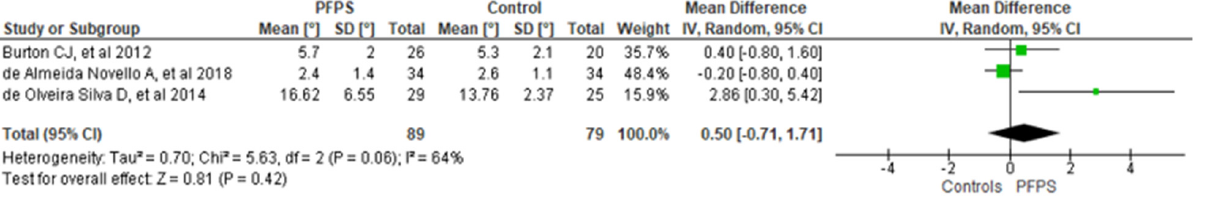
Figure 3. Forest